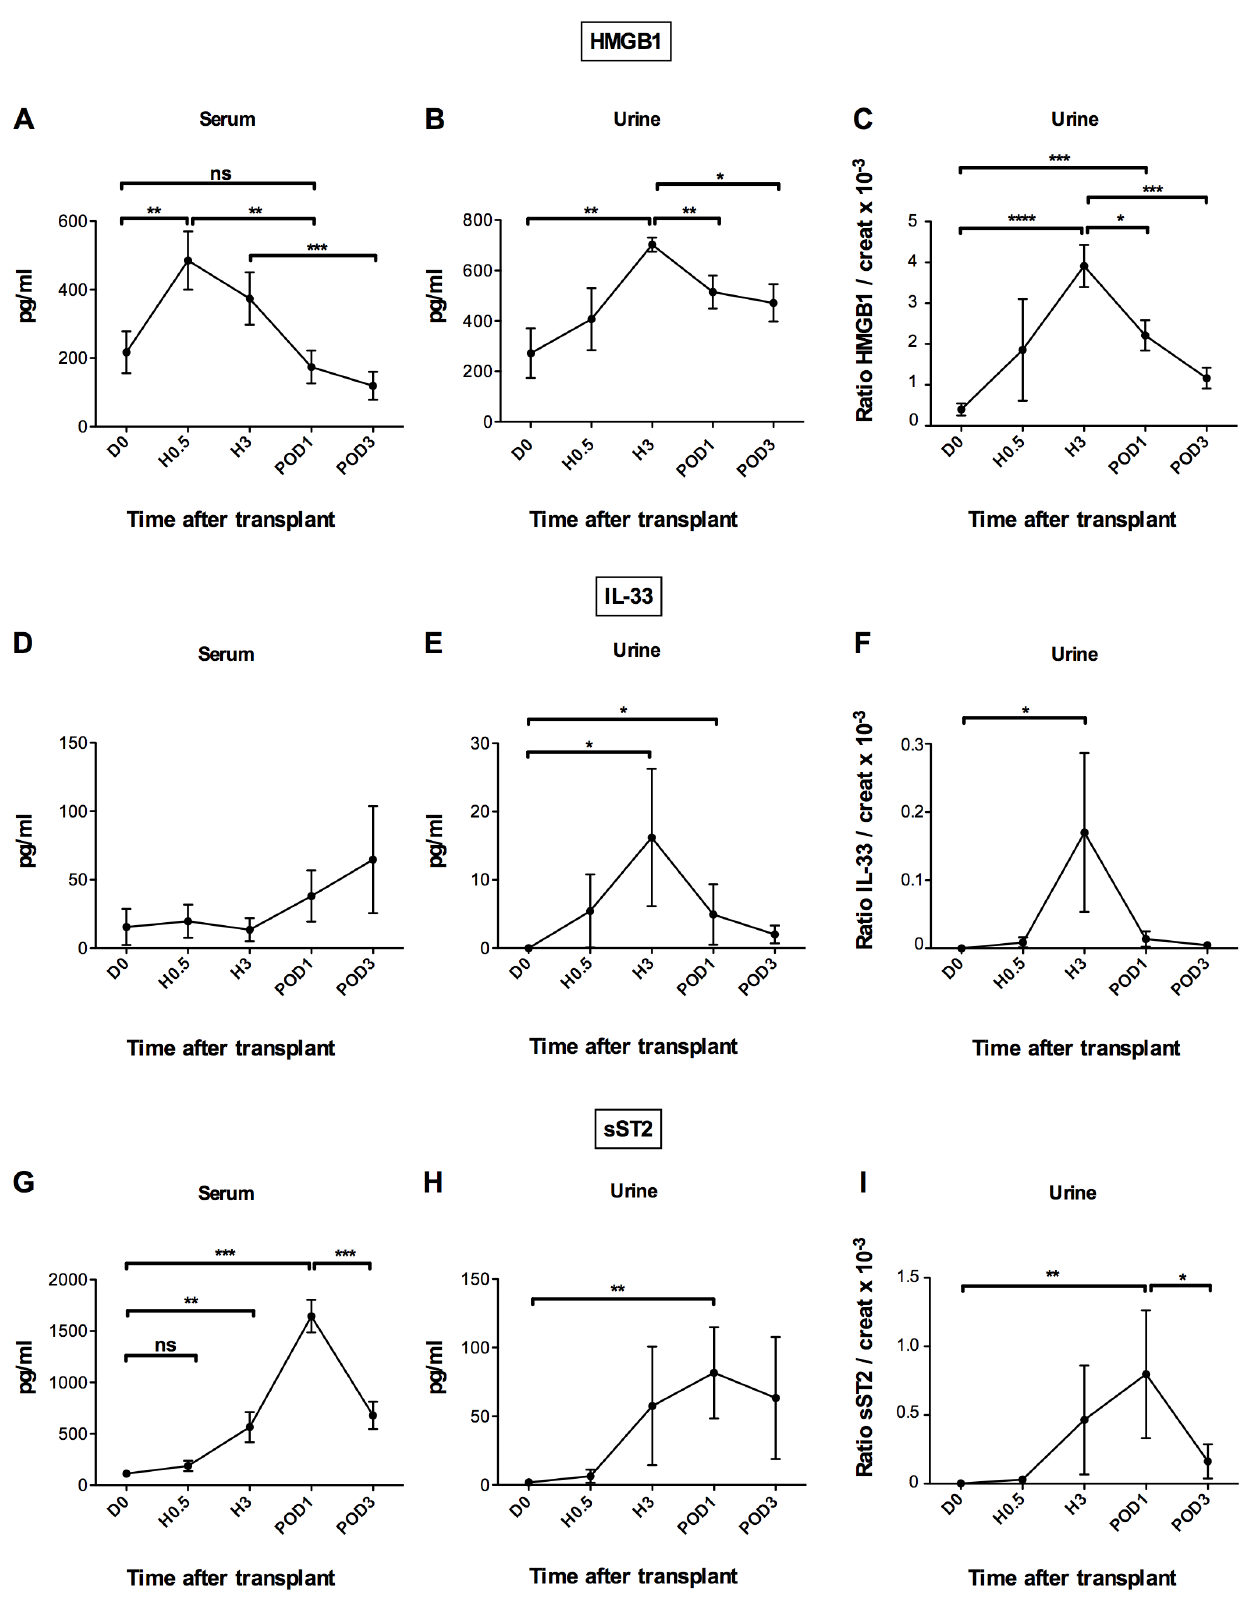
Figure 1. Increased levels of HMGB1, IL-33 and sST2 in serum and urine shortly after renal IRI. HMGB1, IL-33 and sST2 levels were quantified by ELISA in serum and urine of kidney graft recipients (n=26) before transplantation (D0) as control time, and 30 minutes (H0.5), 3 hours (H3), day 1 (POD1) and day 3 (POD3) after transplantation. Serum, urine and urinary molecule/creatinine ratio levels for HMGB1 (A–C), IL-33 (D–F) and